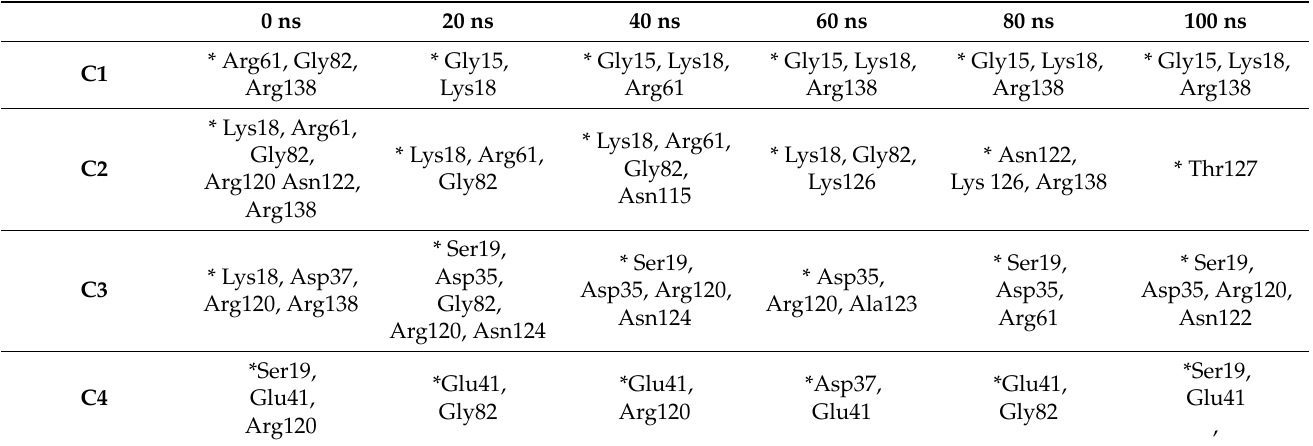
Table 2. Interacting residues through the 100 ns simulation time at selected time frames.